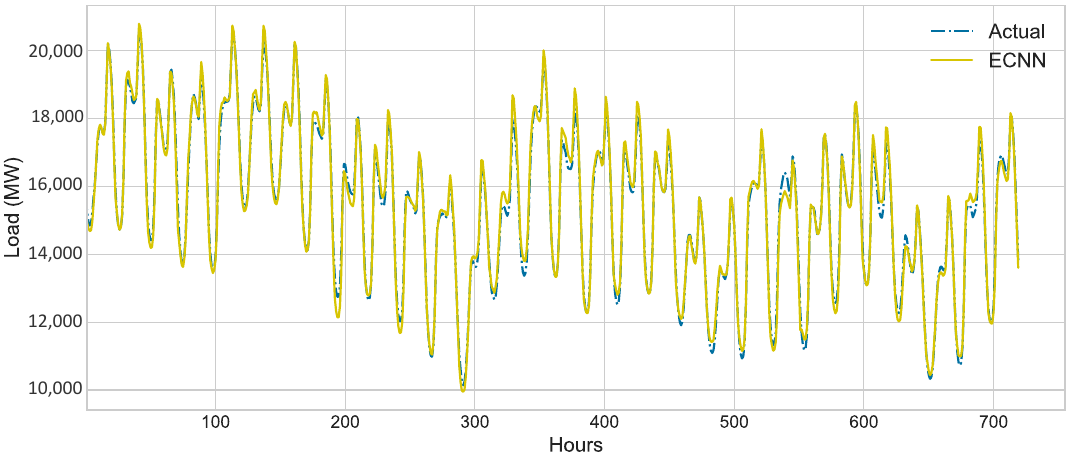
Figure 6. Load Prediction using